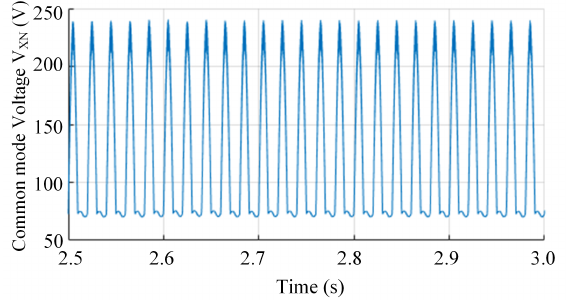
Figure 14. Common mode voltage V XN .